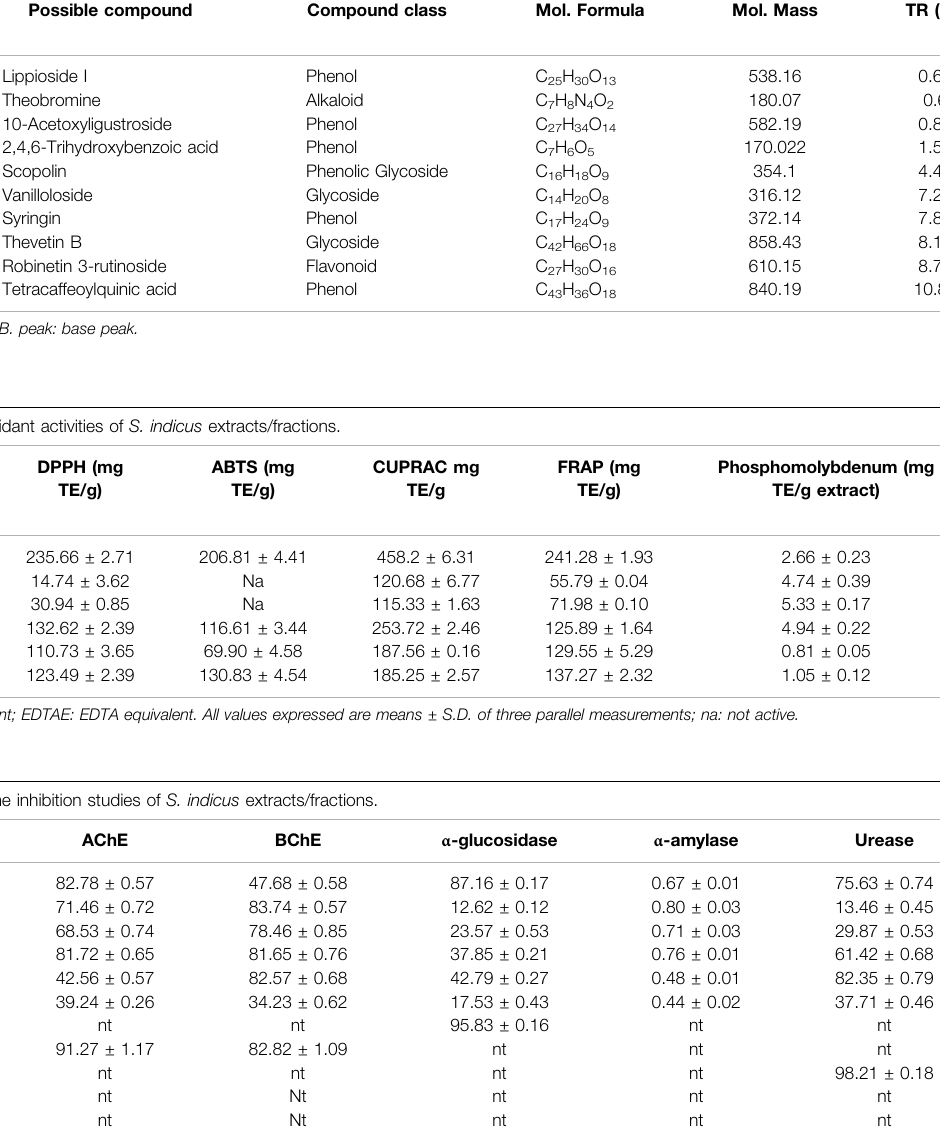
TABLE 4 | UHPLC-MS analysis of S. indicus ethyl acetate fraction (negative ionization mode). Sr. no